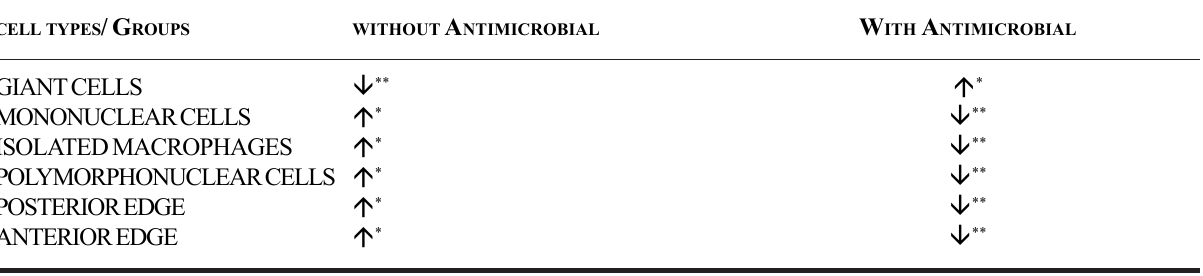
Comparison of group results obtained with and without the use of antimicrobials (CHART 1).